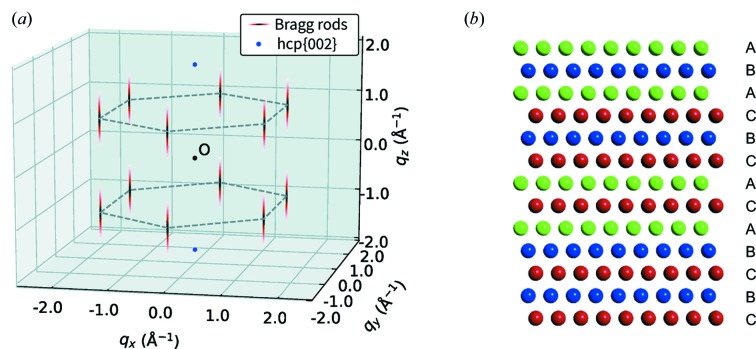
(a) Structure factor when α = 0.5. The structure factor has 12 Bragg scattering rods (red rods) around the {101}hcp reciprocal lattice points and two sharp peaks (blue points) at the {002}hcp reciprocal lattice points. The integral breadth β of the Bragg scattering rods is theoretically calculated to be 0.59 Å−1. (b) An example of the r.h.c.p. structure in the Xe clusters.